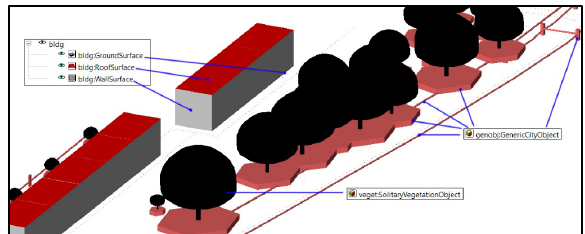
Figure 8. Source CityGML example dataset